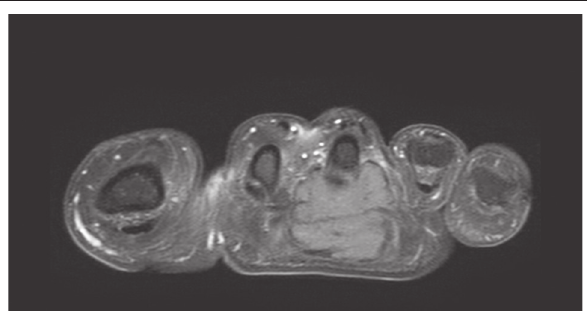
FIGURE 11: Short axis T1 FS MR image of the foot demonstrating a giant cell tumour in the tendon sheath of the 3rd toe.